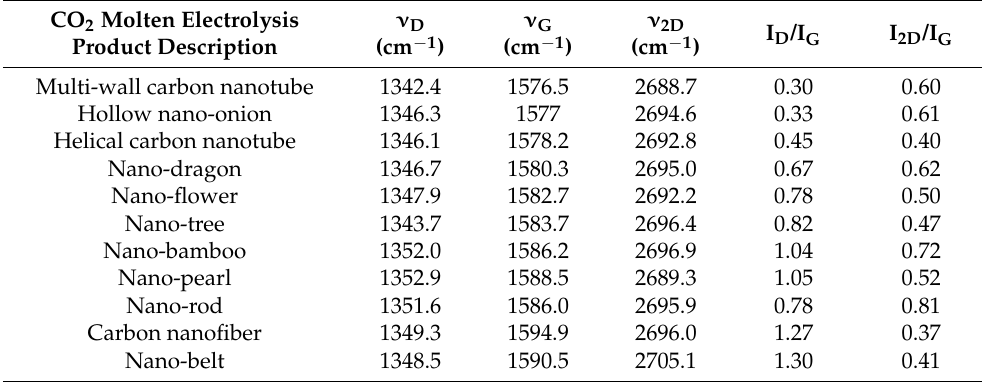
Table 4. Raman spectra of a diverse range of carbon CNMs formed by molten